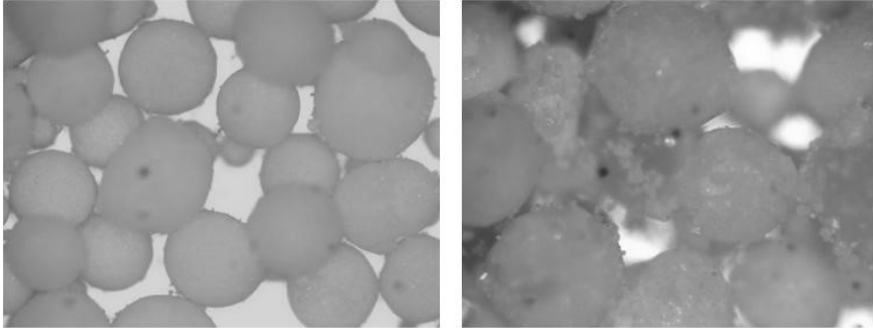
Figure 2. Microscopical view of paraffin based PCM: DS5001 X ( left ) and PX27 ( right ).